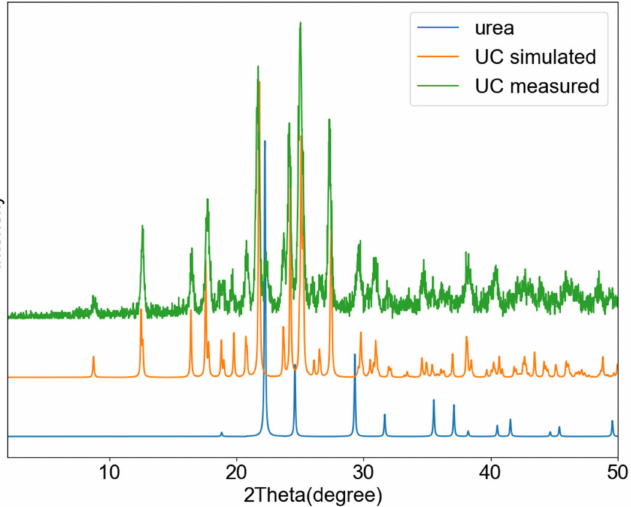
Figure 3. PXRD profiles of UC obtained by grinding ( green ), the simulated pattern of the UC cocrystal ( orange ), and urea ( blue